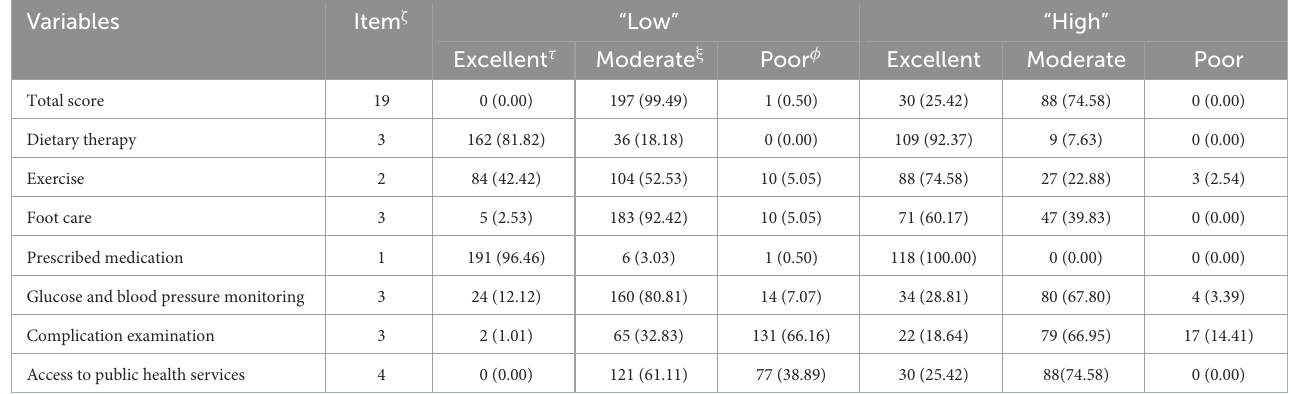
TABLE 3 Distribution characteristics of ITP behavior in two clusters.